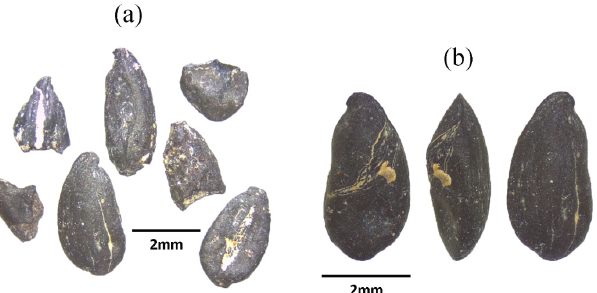
Figure 6. Flax ( Linum usitatissimum ) from Petras: ( a ) whole and fragment seeds; ( b ) detailed views of a whole seed.